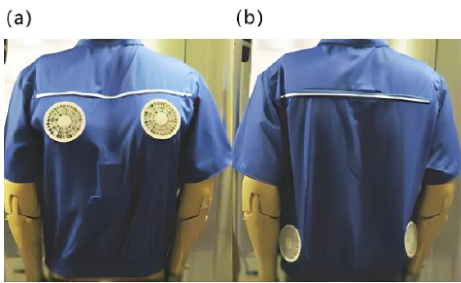
Figure 2. Ventilation jacket [9]. ( a ) The fan was set on the back. ( b ) The fan was set at the waist.